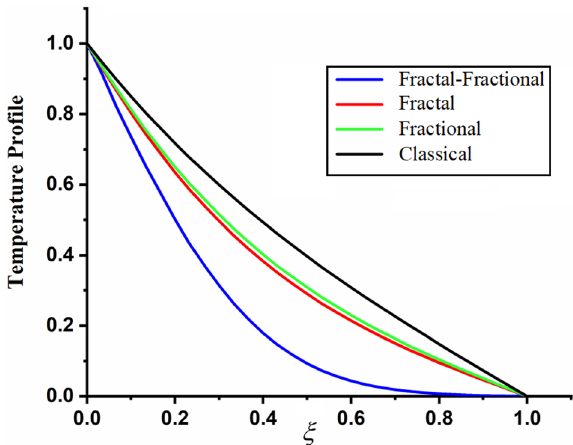
Figure 11. The comparison between fractal-fractional, fractal ,fractional and classical temperature when α = 0.5 , β = 0.5 , Re = 3.2 , t = 0.2 and Pr = 0.5 .